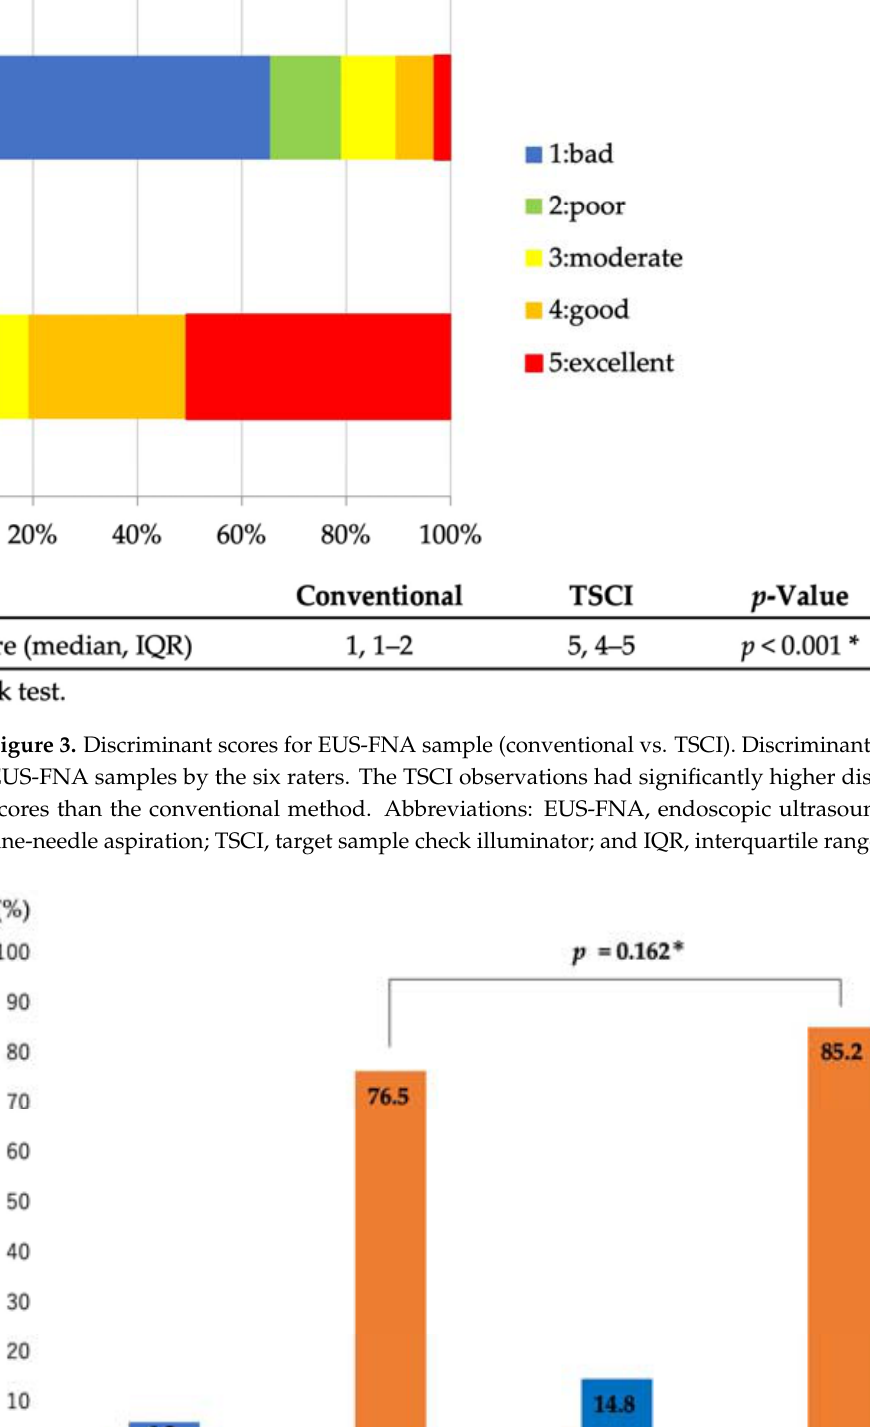
Figure 4. Differences from experience in high discriminant scoring cases. In high ‐ scoring cases ( ≥ 4), there was no significant difference between the novice and experienced raters. * Chi ‐ square test. Abbreviations: TSCI, target sample check illuminator.